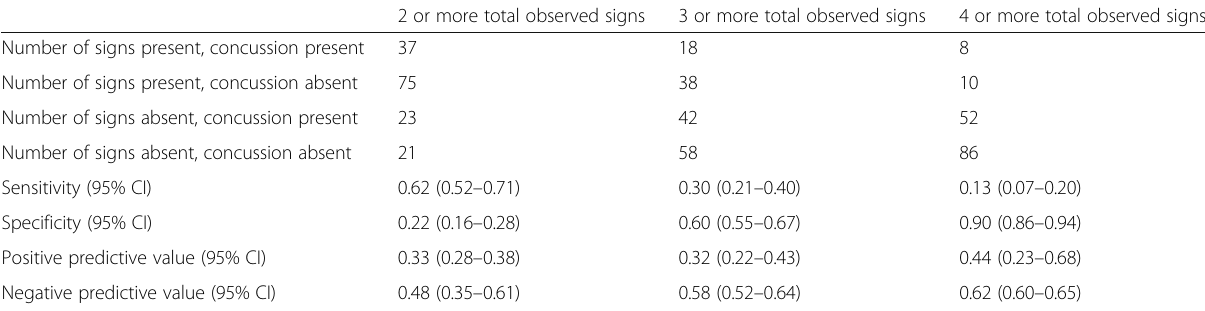
Table 3 Sensitivity, specificity, positive predictive value, and negative predictive value of the total number of observed signs (two or more, three or more, four or more) that led to the diagnosis of concussion